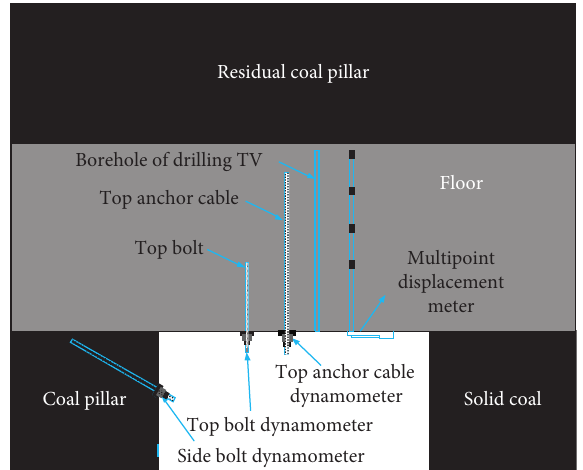
Figure 4: Arrangement of the monitoring